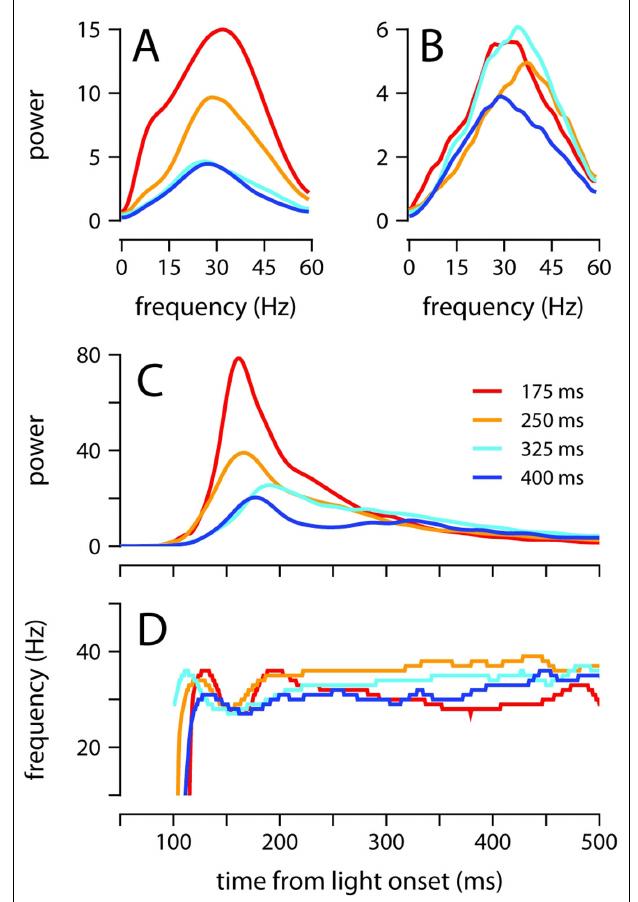
FIGURE 5 | Oscillatory properties of the conditioned eyelid response. (A) Average power spectrum of eyelid acceleration during the first 200ms, and (B) from 200 to 500ms after light onset. Spectra are plotted for each ISI separately. (C) Maximum power, and (D) dominant frequency of oscillation, in the eyelid acceleration signal.The value plotted at each moment in time in (C,D) is computed over a ∼ 50ms spectrogram window centered at that moment (see Materials and Methods). Each ISI plotted separately. For all plots, power is in units of (fraction eyelid closure/s 2 ) 2 Hz − 1 × 10 4 , and color code indicates trained ISI as shown in (C)